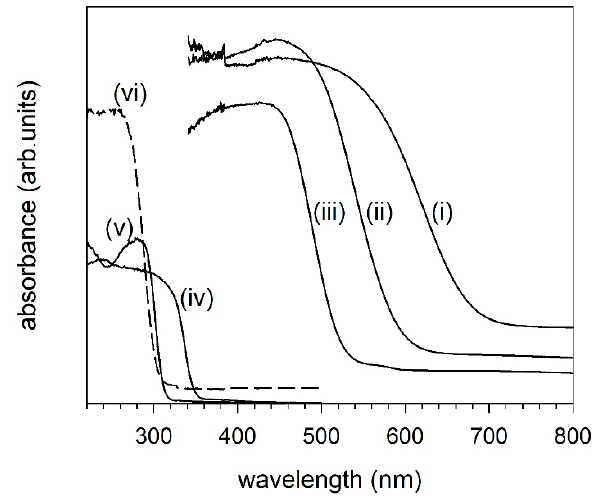
Figure 1. Diffuse reflection absorption spectra for ( i ) BaTaO 2 N, ( ii ) SrTaO 2 N, ( iii ) CaTaO 2 N, ( iv ) KTaO 3 , ( v ) NaTaO 3 , and ( vi ) TaO 2 F.